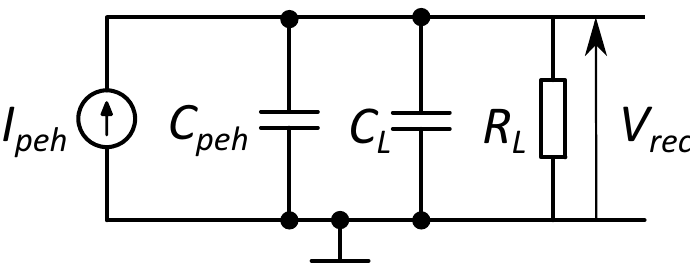
Figure 6. Equivalent of PEH during power extraction